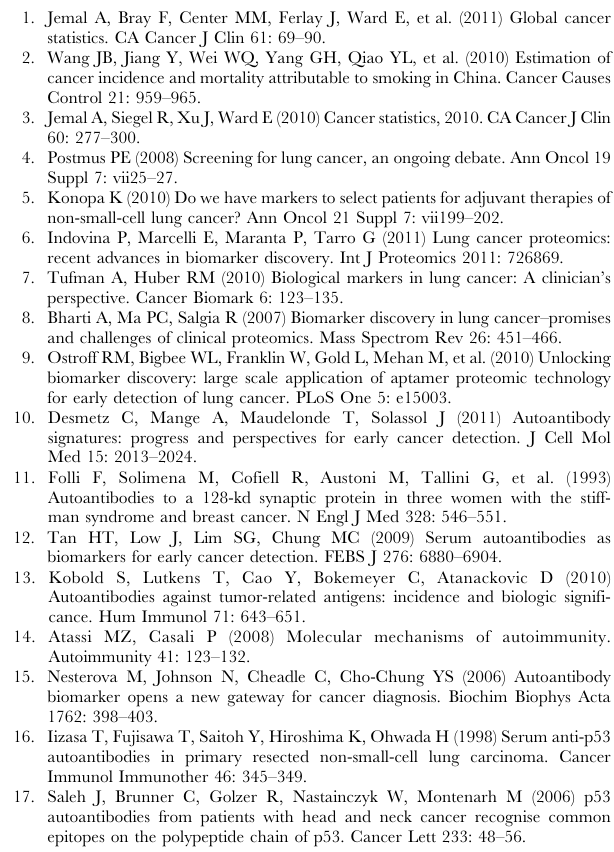
Figure S1 Optimal Serum dilution for ELISA technique. Optimal dilution was determined by titration technique. Dilution experiments showed that the APE1-AAbs titer differed from one patient to another. Two samples (p083487, p084393) from healthy controls displayed a low titer of APE1-AAbs while another two samples (p080195, p080643) from NSCLC patients had a high titer of APE1-AAbs. P080195 sample displayed a positive signal until diluted to 1:1000, whereas p080643 showed a strong signal for a dilution of 1:2000. These serum samples could be diluted 1:1000 and still yield a positive signal. The optimal dilution of serum we selected was 1:300.